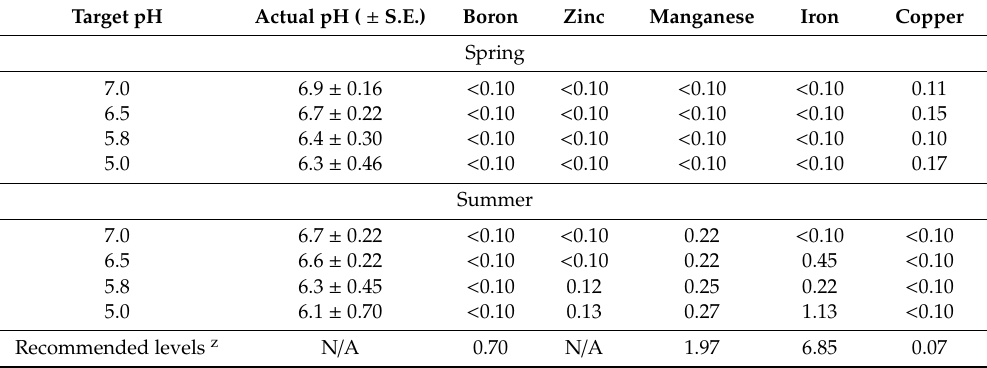
Table 7. End-of-season micronutrient analysis (mg · L –1 ) of aquaponic irrigation water at four target pH treatments.